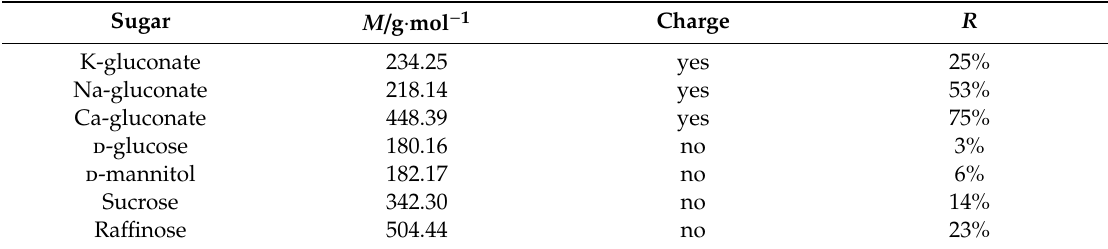
Table 2. Retention R of the sugars tested with PILs BD2.